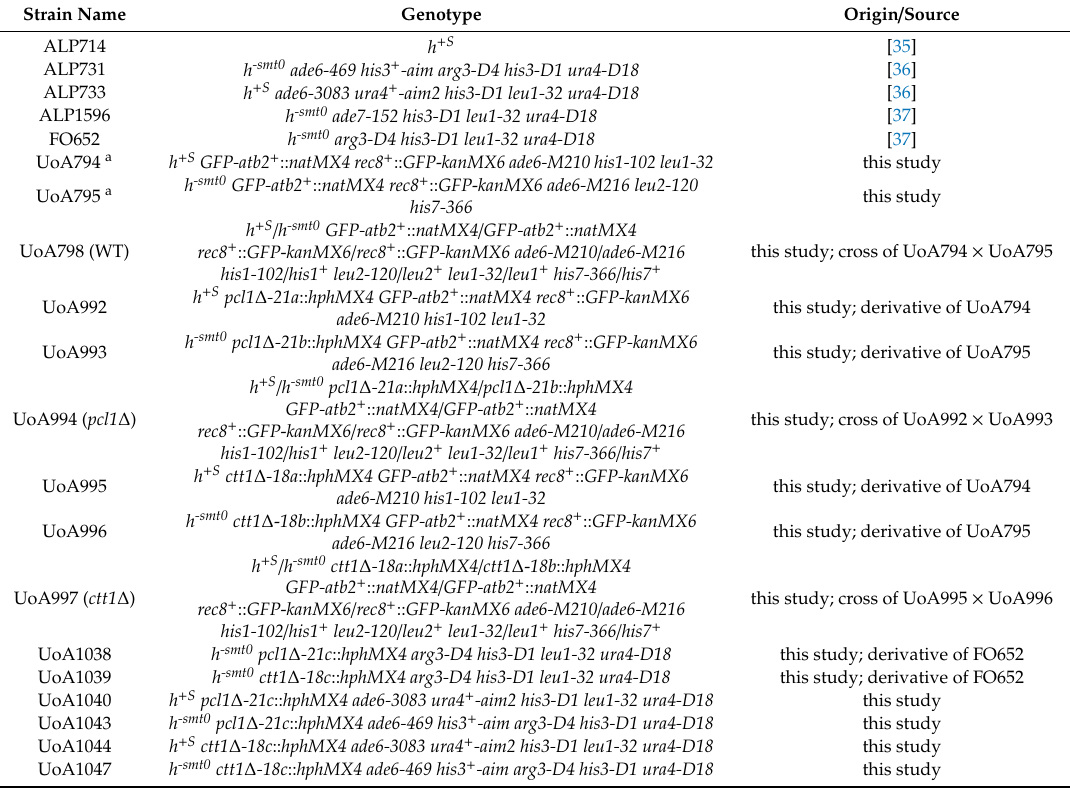
Table 1. Schizosaccharomyces pombe strains and their